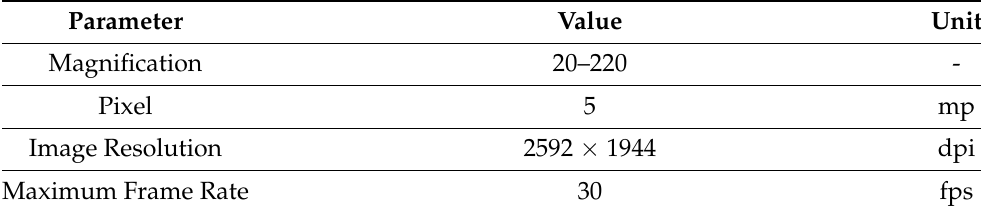
Table A2. Main Technical parameters of Dino-Lite AM7115.